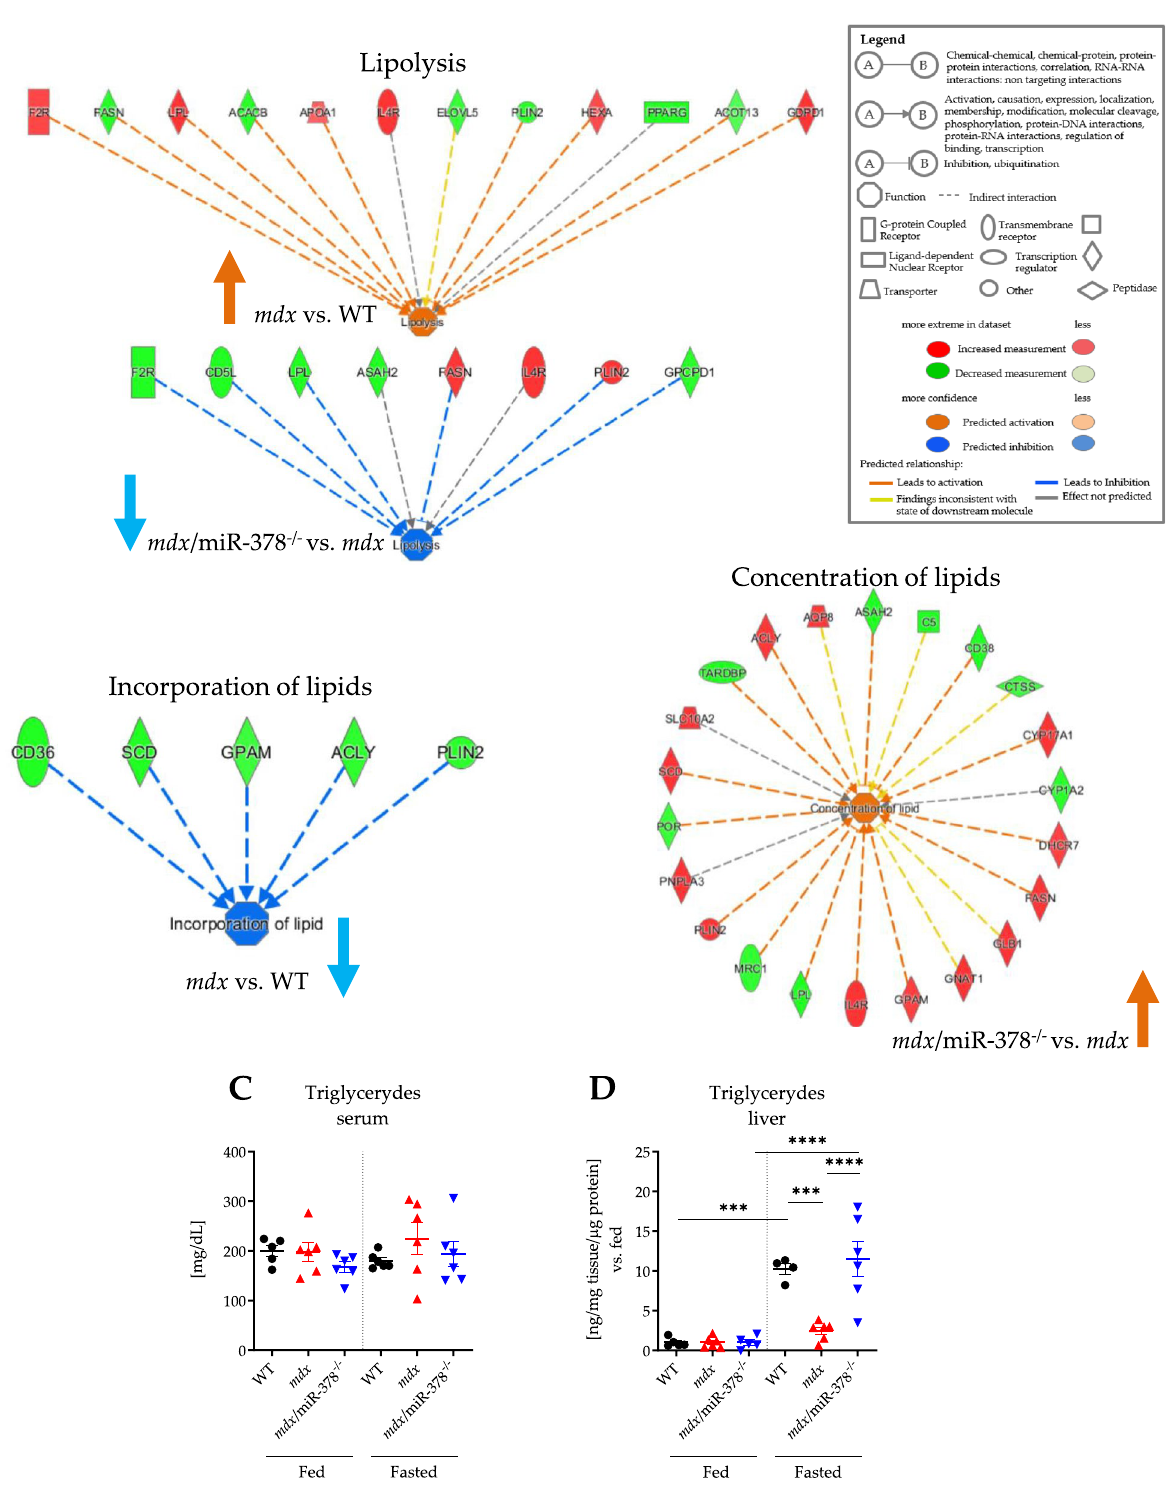
Figure 6. Disturbances in lipid metabolism in the liver of the mdx mice are affected by the additional lack of miR-378. ( A ) Ingenuity pathway analysis (IPA) revealed increased and decreased lipolysis in mdx vs. WT ( p -value = 1.54 × 10 –4 ) and mdx /miR-378 −/− vs. mdx ( p -value = 1.28 × 10 −5 ) livers, respectively. ( B ) Incorporation of lipids was shown to be lower in the liver of mdx mice ( p -value = 6.33 × 10 –5 ) whereas the concentration of lipids was higher in mdx /miR-378 −/− vs. mdx livers ( p -value = 6.44 × 10 –5 ). Triglyceride levels were assessed under non-fasting (fed) conditions and after overnight fasting (fasted) in ( C ) the serum; n = 5–6/group and ( D ) in the liver; 4–6/group. Data are presented as mean ± SEM. *** p < 0.001; **** p < 0.0001 by one-way ANOVA with Tukey’s post-hoc